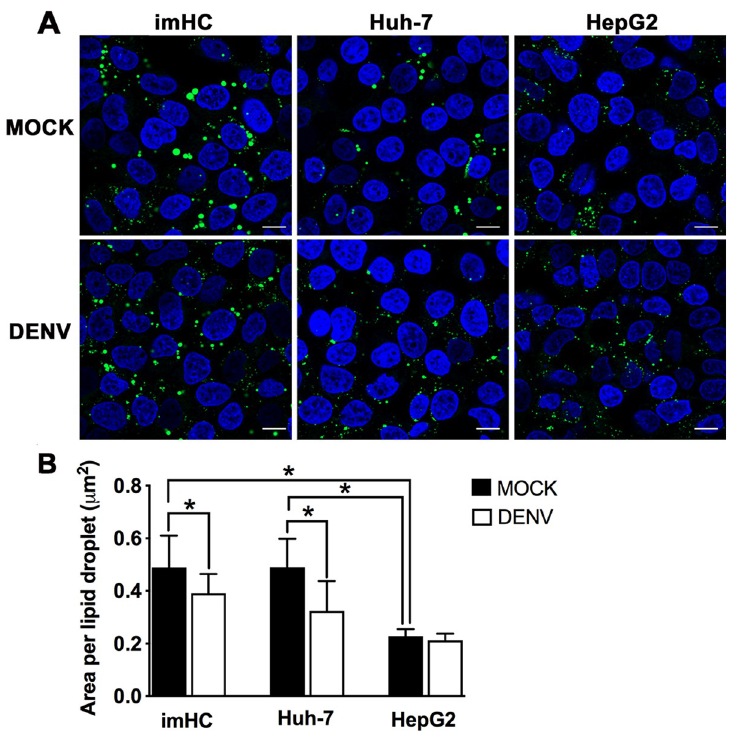
Fig 6. Changes in lipid droplet areas in imHC and hepatoma cell lines upon DENV infection. ( A ) Representative images from the confocal microscopic analysis of lipid droplets stained with BODIPY 493/503 in the three cell lines cultured for 48 h under mock-infected (top panel) or DENV-infected conditions (MOI of 0.1) (bottom panel). Nuclei were stained with Hoechst 33342. Scale bar = 10 μ m. ( B ) Area per lipid droplet of each cell type pre- and post-DENV infection was further analyzed using Image J software. The data shown are the mean ± S.D. values of the areas of lipid droplets analyzed from a total of 300–400 cells for each cell type. Asterisks indicate statistically significant differences ( P < 0.05) of area per lipid droplet among the three cell types pre-infection as well as between the mock and DENV- infected conditions of each cell type. droplets [51]. Neutral loss scans were performed to detect TAGs containing the four most common fatty acyl chains, including palmitic (C16:0), palmitoleic (C16:1), oleic (C18:1), and stearic (C18:0) [52]. Fig 7A shows a representative mass spectral profile from the neutral loss scanning of imHC extracts in the m/z range of 750–980, a mass range that covers all major TAGs [53,54]. The TAG profiles from the four neutral loss scans were similar among the three hepatic cell lines and PHHs but different from those of non-hepatic cell types (U87-MG and PBMCs), especially for TAG species with C16:0 and C18:0 ( S6 and S7 Figs ), suggesting that there is a characteristic TAG profile specific to hepatocytes. The m/z values in the spectra were used to assign probable identities of ammonium TAG adducts based on the LIPID MAPS data- base (www.lipidmaps.org). The details of TAG species detected in this study are shown in S1 Table . Major molecular species of TAGs found in each neutral loss scan (labeled in large font in Fig 7A ) were selected for further comparison of their relative abundances in the three cell lines upon DENV infection. In this study, we compared abundances of TAGs based on their peak areas relative to that of dipalmitoylphosphatidylcholine [DPPC or PC (C16:0/16:0); m/z 734], a major phospholipid that exists in the three cell lines and shows no change upon DENV infection ( S8 Fig ). The overall relative abundances of TAGs, containing either C16:0, C16:1, C18:0 or C18:1, were similar among the three hepatic cell types prior to DENV infection ( Fig 7B ). However, following DENV infection (MOI of 0.1, 48 h), only imHC revealed a statistically